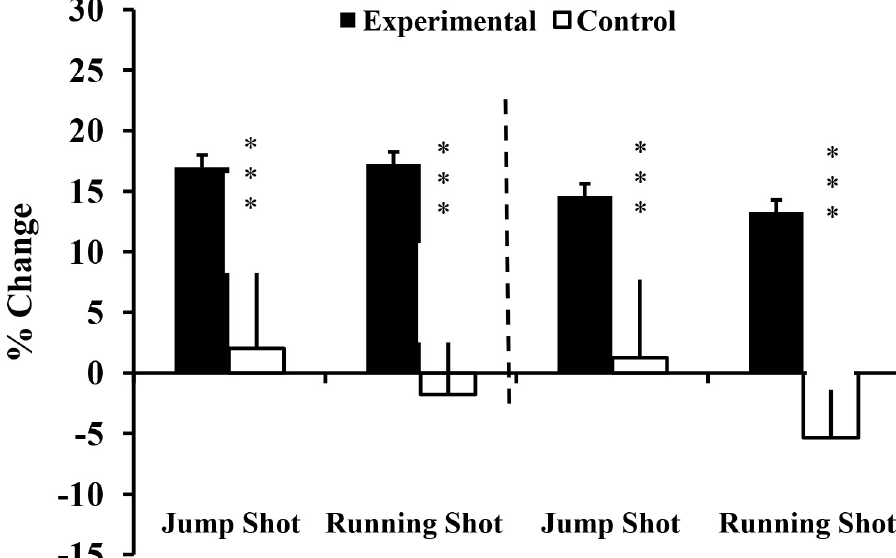
Fig 5. Percentage change of ball throwing velocity at T 1 , and T 2 for Experimental (E) and Control (C) groups. T 0 : before training; T 1 : after 10 weeks of resistance training; T 2 : after 2 weeks of tapering; ��� : ANOVA group x time interaction significantly different between E and C at the level of p < 0.001.